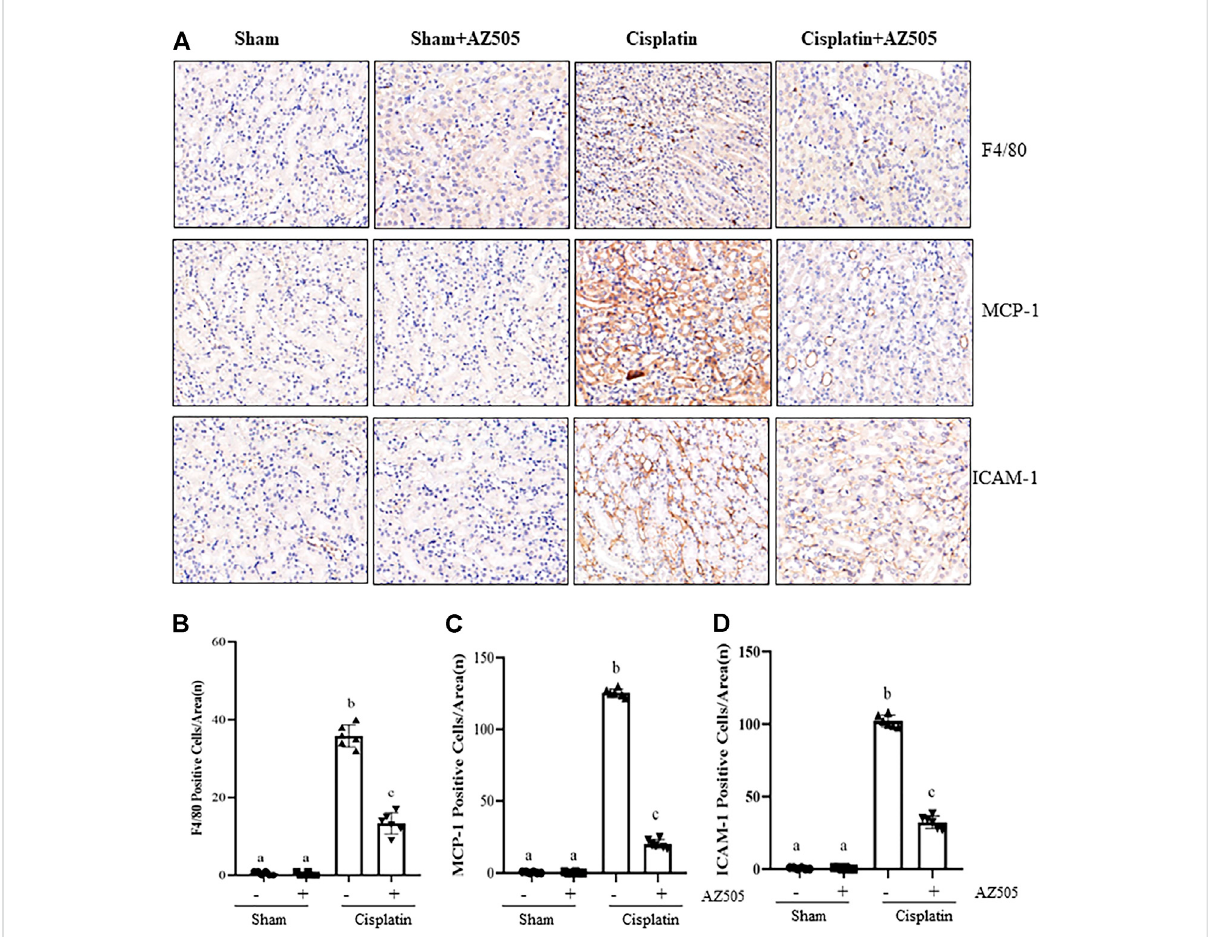
AdministrationofAZ505suppressescisplatin-inducedin fl ammationinthekidneyfollowingcisplatintreatment. (A) Photomicrographsillustrate immunohistochemistry staining of F4/80-positive, MCP-1-positve and ICAM-1-positive cells in the kidney tissues treated with or without AZ505. (B – D) ThegraphshowsthenumberofF4/80-positivemacrophages (B) ,MCP-1-positvecells (C) andICAM-1-positivecells (D)